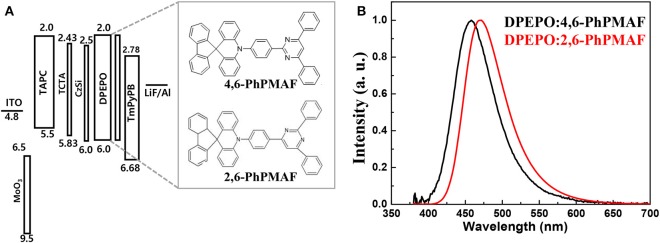
(A) Energy-band diagram and (B) normalized electroluminescence intensity of blue-emitting TADF OLEDs with DPEPO:4,6-PhPMAF and DPEPO:2,6-PhPMAF emitters.